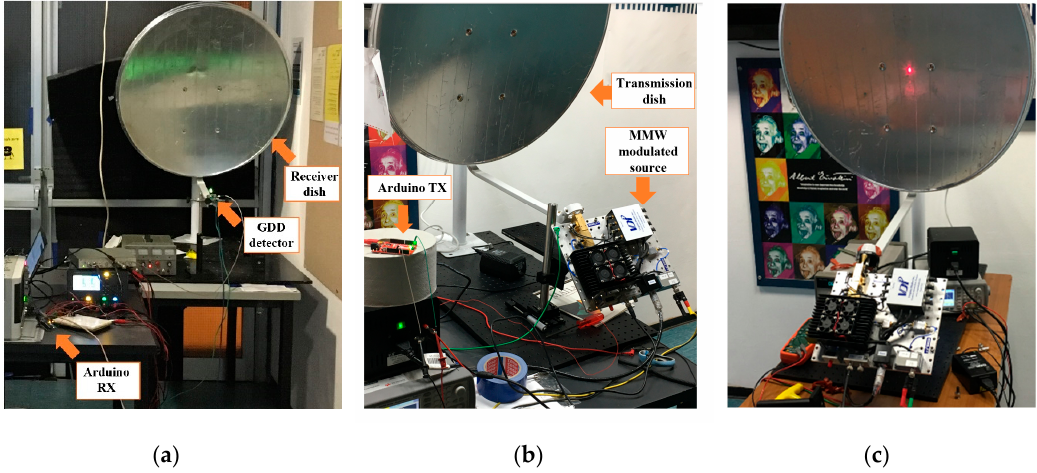
Figure 3. The dish antennas setup for the receiver ( a ) and transmission side ( b ) in the experiment. ( c ) Demonstration of the alignment process.